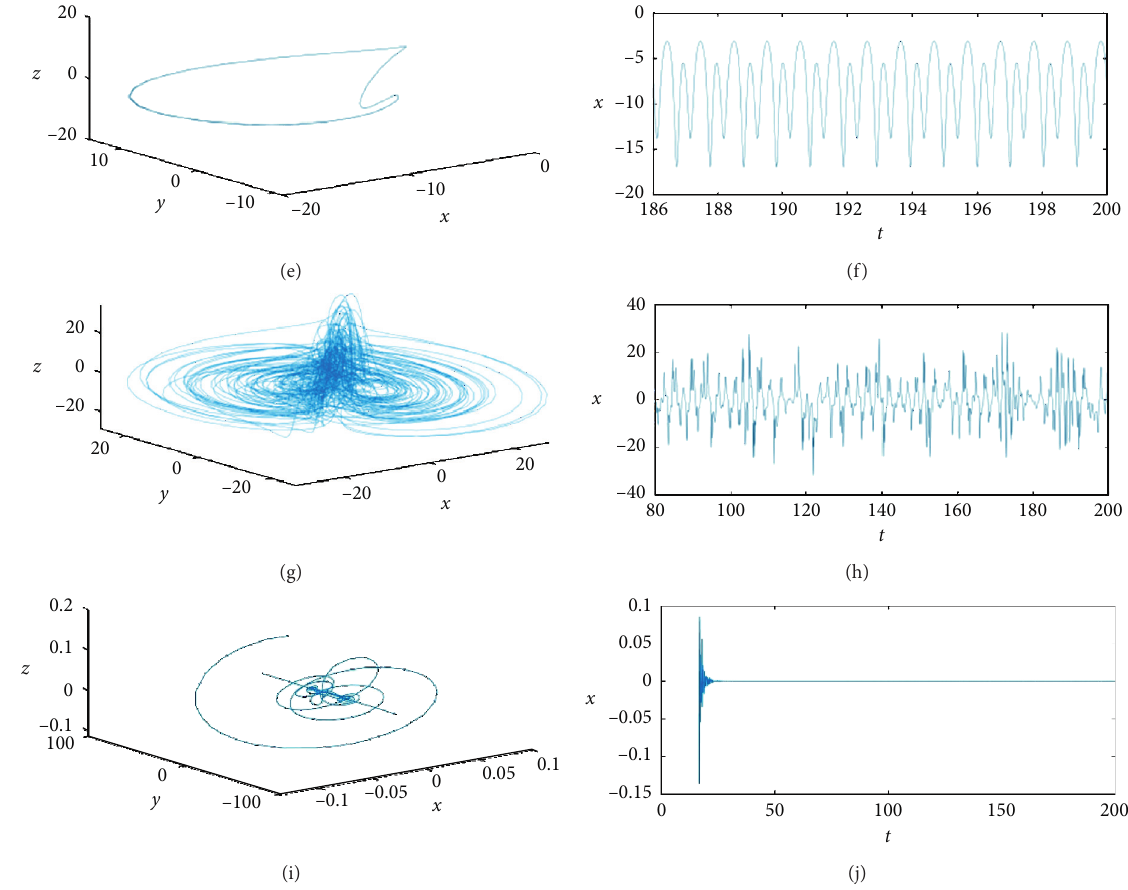
Figure 6: System phase diagram and time course diagram for different values of time-lag risk intensity e . (a) Phase diagram of the system at e � 0.2. (b) Time course diagram at e � 0.2. (c) Phase diagram of the system at e � 1. (d) Time course diagram at e � 1. (e) System phase diagram at e � 1.8. (f) Time course diagram at e � 1.8. (g) Phase diagram of the system at e � 6. (h) Time course diagram at e � 6. (i) System phase diagram at e � 9.5. (j) Time course diagram at e �